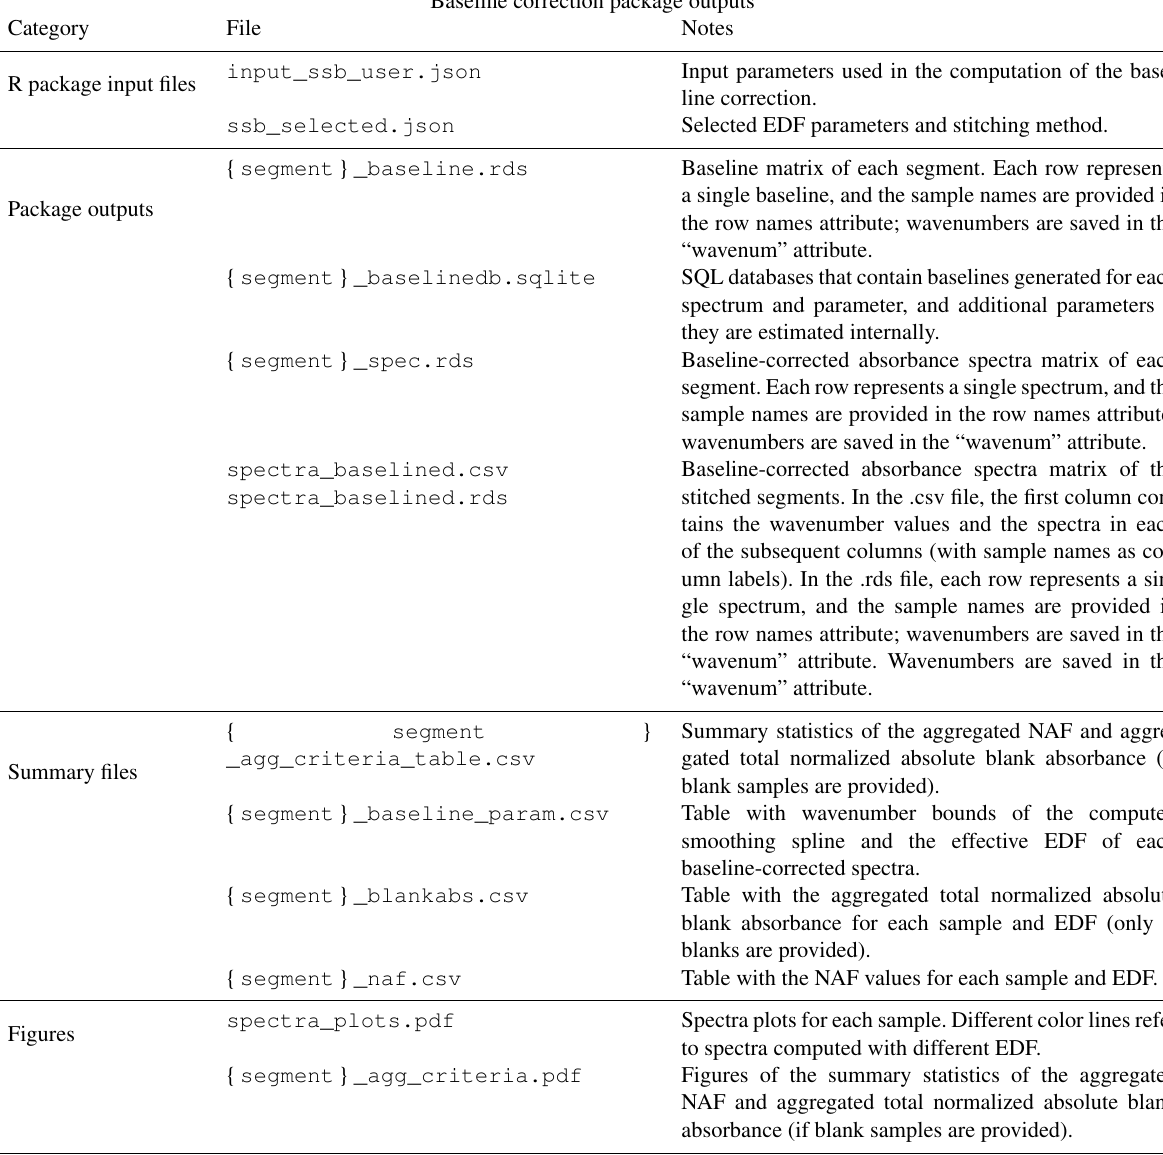
Table 2. List of outputs of the baseline correction chemometric package. { segment } denotes the segment label.